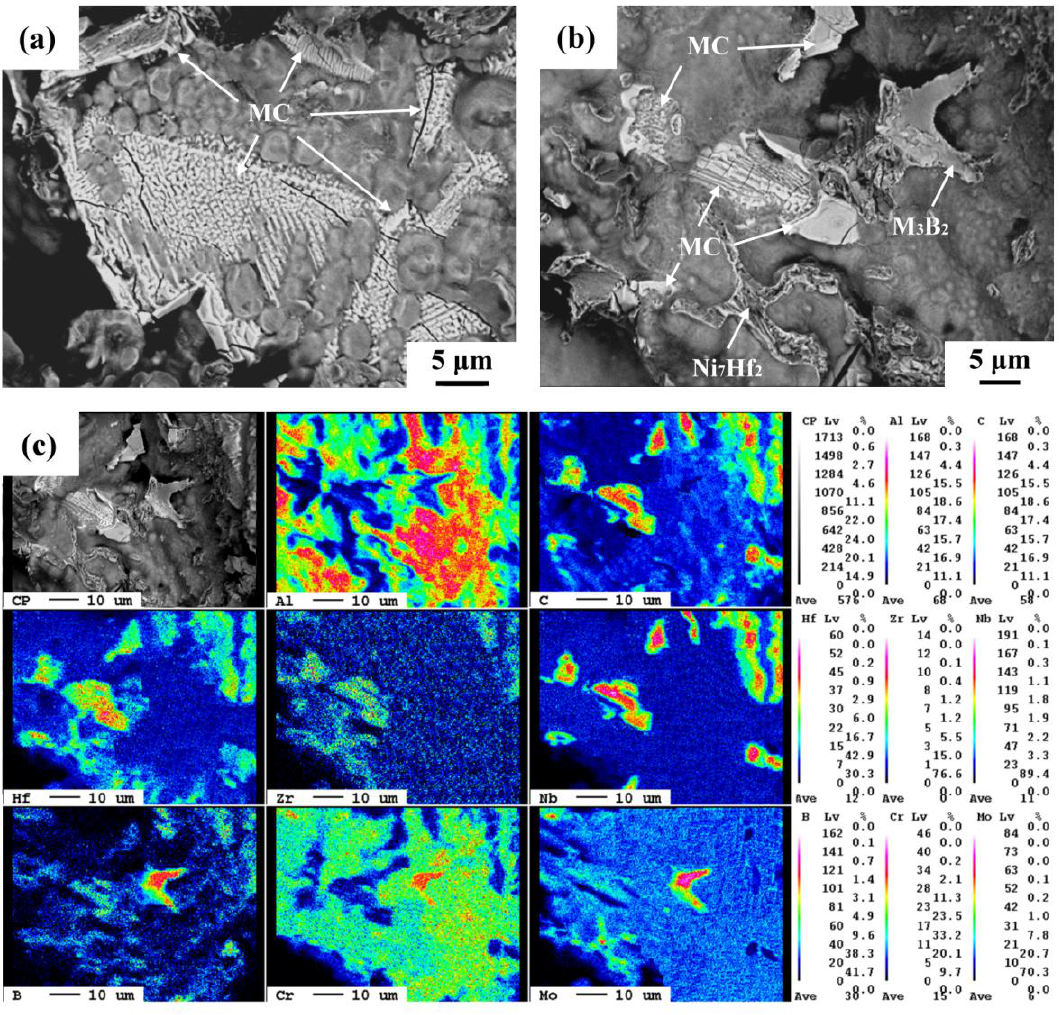
Figure 7. ( a , b ) SEM fractographs of liquated cracks and ( c ) the associated elemental mappings determined by EPMA.